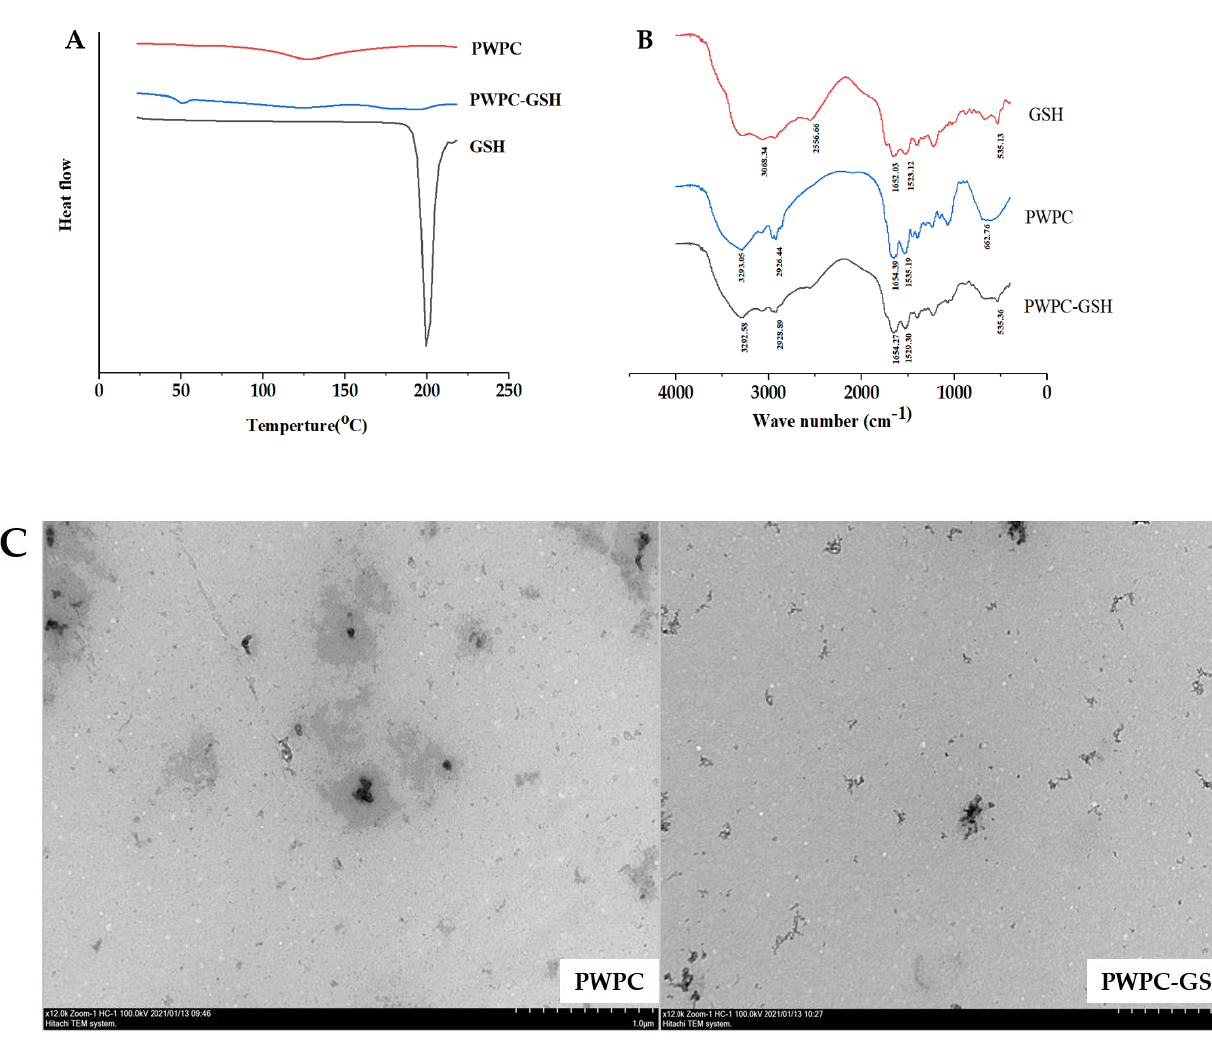
Figure 2. ( A ) Differential scanning calorimetry (DSC), ( B ) FT-IR spectrum, ( C ) TEM image of PWPC and PWPC-GSH.